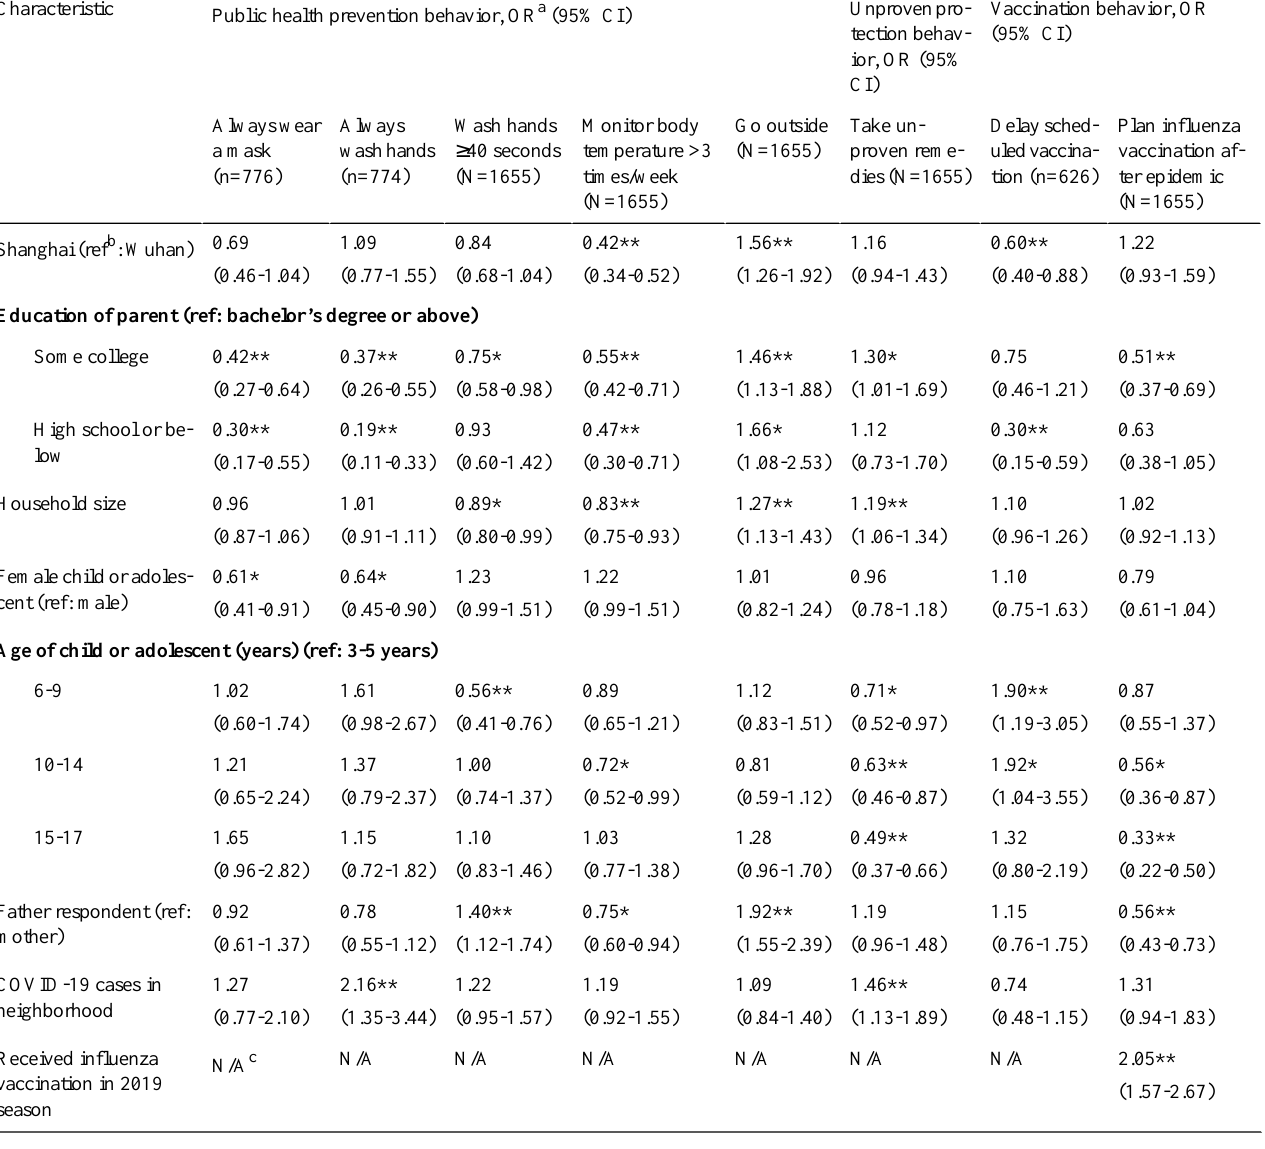
Table 3. Factors associated with prevention, unproven protection, and vaccination behaviors among respondents in Wuhan and Shanghai during the COVID-19 epidemic by multivariate logistic regression, March